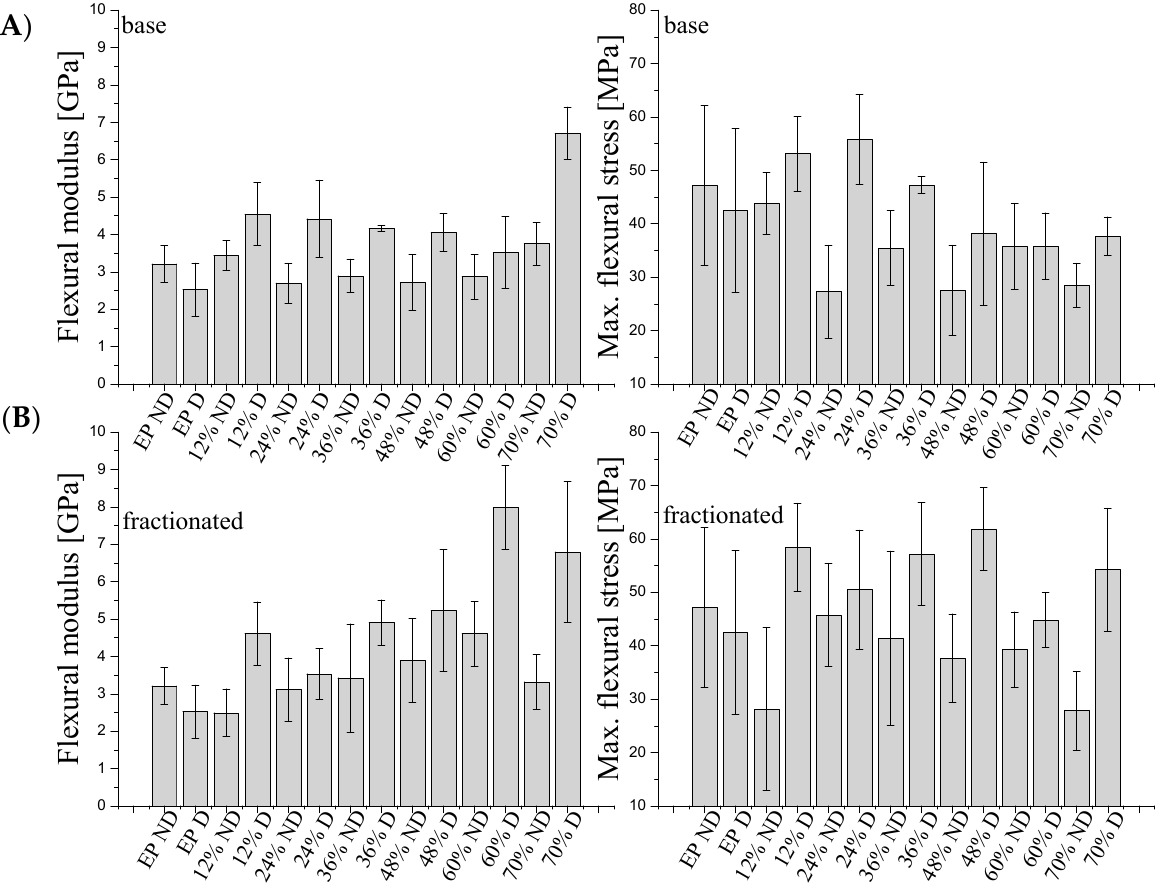
Figure 14. Flexural modulus and max. bending stress for degassed and non-degassed (“D” and “ND”) composites containing base ( A ) and fractionated ( B ) samples diatoms.